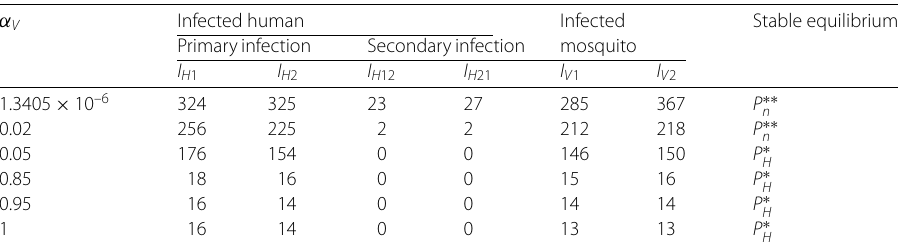
Table 5 Effect of α V on the number of infected populations: I H 1 , I H 2 , I H 12 , I H 21 , I V 1 , and I V 2 at steady state using the multi-serotype dengue model (2.4)–(2.5) α V Infected human Infected